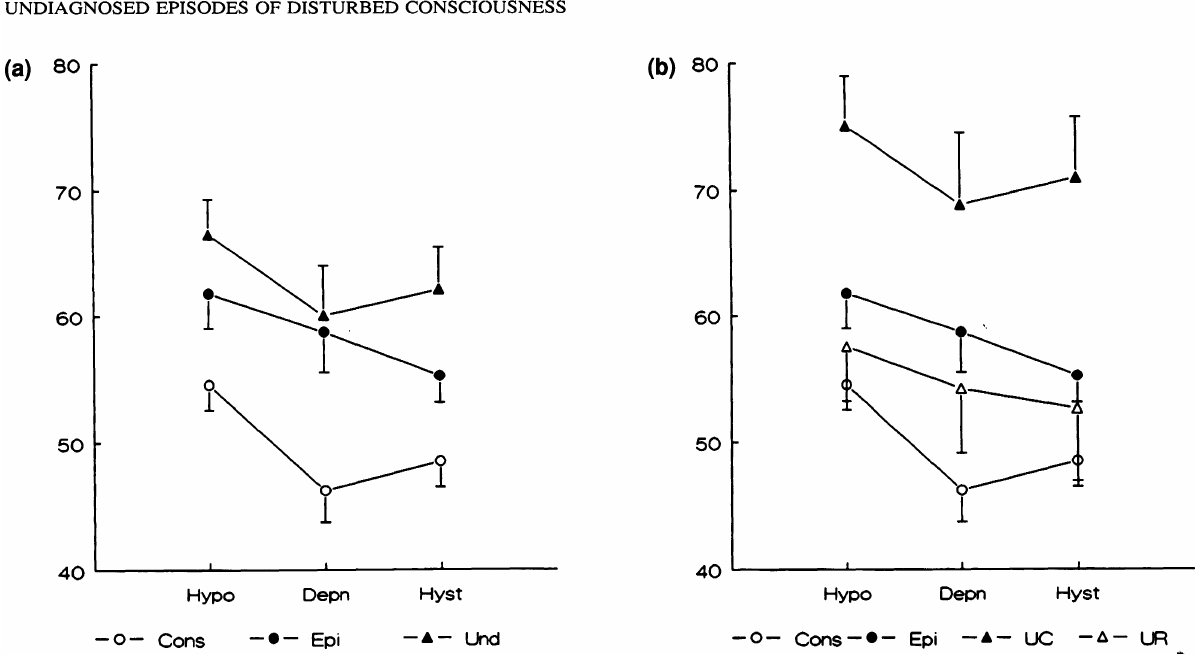
FIG. 2. (a) Group mean Minnesota Multiphasic Personality Inventory (MMPI) scale scores for hypochondriasis (hypo), depression (depn) and hysteria (hyst) in healthy controls (Cons), epilepsy controls (Epi) and patients with undiagnosed attacks (Und). Note the elevated scores in both the epilepsy controls and undiagnosed patients compared with healthy controls and the "conversion V" pattern in the undiag nosed patients. Vertical bars show standard error. (b) Group mean MMPI scale scores for undiagnosed patients by outcome of clinical follow-up. Patients whose attacks resolved spontaneously without treatment (UR) have lower scores than epilepsy controls (Epi) and do not differ significantly from healthy control subjects (Cons). Patients who have continuing unexplained attacks (UC) have markedly higher scores for hypochondriasis and hysteria and show "conversion V"